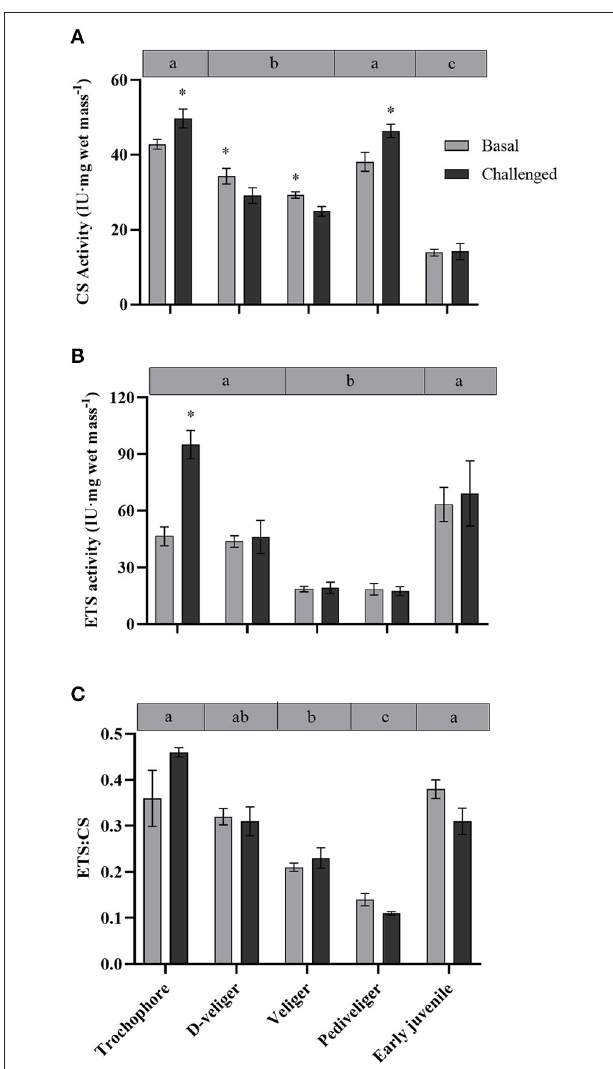
FIGURE 4 | (A) CS, (B) ETS activity, and (C) ETS:CS ratio throughout larval development and in early juveniles from the scallop Argopecten purpuratus. Different lowercase letters inside bars at the top of the graph indicate significant differences among basal developmental stages ( P < 0.05). Asterisks indicate significant differences between control and challenged groups ( P < 0.05). n = 6 per